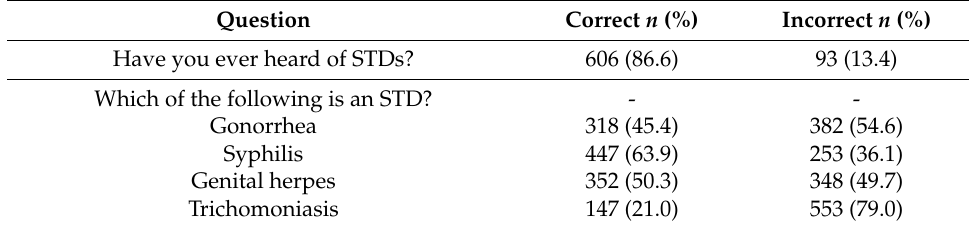
Table 1. University students’ knowledge of sexually-transmitted